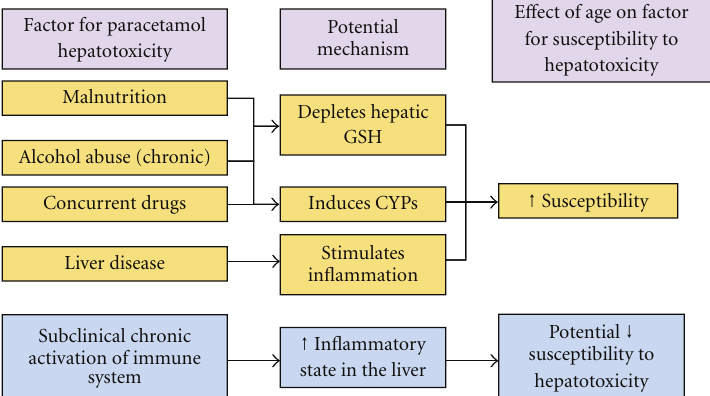
Figure 3: The e ff ect of age on risk factors for paracetamol-induced hepatotoxicity and the potential mechanism through which they may